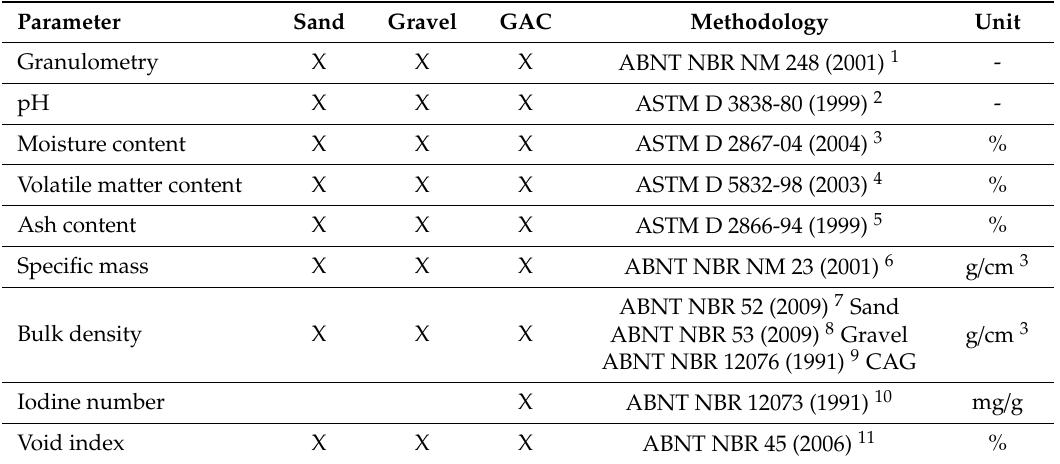
Table 1. Parameters and the reference methodologies used to characterize the filter materials.